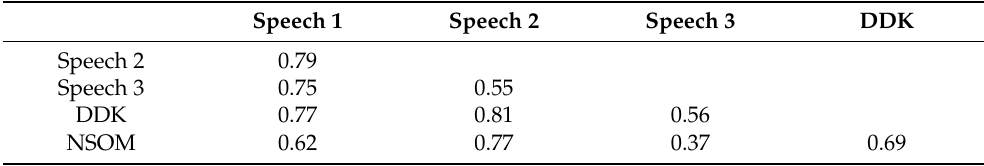
Table A9. Between-factor correlations for the three CFA factors corresponding with the EGA di- mensions plotted in Figure 3.